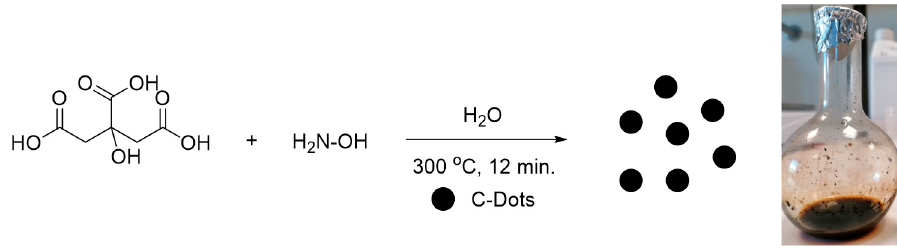
Figure 1. Hydrothermal synthesis of C-Dots.